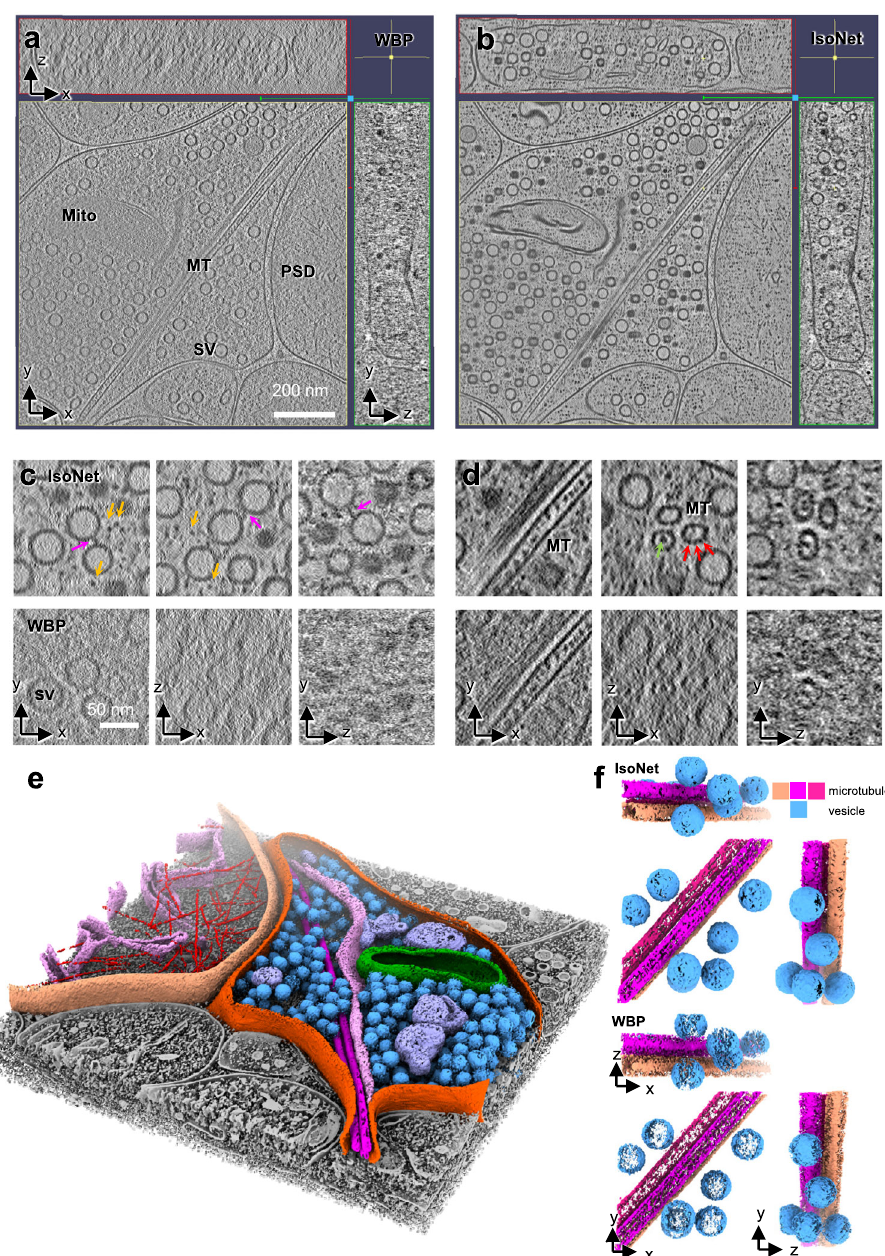
Fig. 5 | IsoNet recovers missing information in the tomograms of neuronal synapses. a , b Orthogonal slices of a synaptic tomogram reconstructed with WBP ( a ) and IsoNet ( b ). SV: synaptic vesicle; Mito mitochondria, MT microtubule, PSD postsynaptic density. c , d Zoomed-in orthogonalslices of WBP reconstruction and IsoNet-produced reconstruction. Magenta arrows: vesicle linker; Orange arrows: